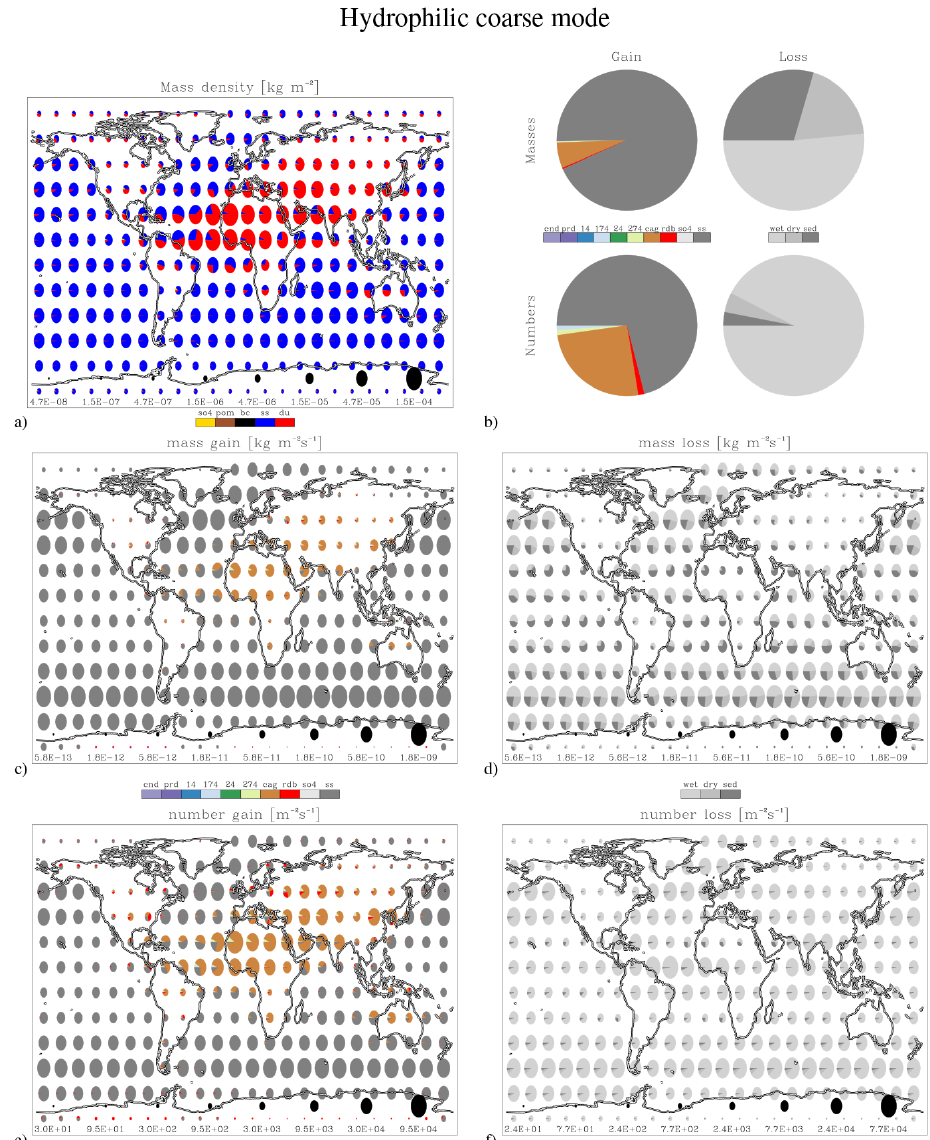
Figure 22. Global distribution of annual burdens (a) and tendencies ( b, c, d, e and f ) of the hydrophilic coarse mode. The colors indicate either species (defined in Table 3) or processes (defined in Table 2). The pie chart shows fractional contributions, while the radius of the pie indicates total column burden or total column tendency (logarithmic scale as shown in black at the bottom of panels a, c, d, e and f ). Panel b shows a global average of the